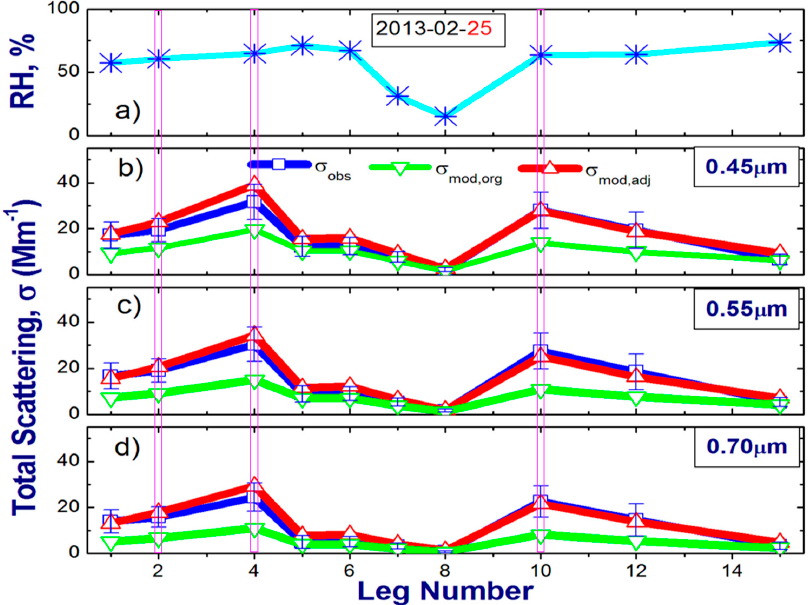
Figure 8. Ambient RH ( a ) and spectral values ( b – d ) of the total scattering coefficient measured (blue) and calculated for the original (green) and RI-based adjusted (red) size distributions for FLs on 25 February 2013 at three wavelengths: ( b ) 0.45, ( c ) 0.55, and ( d ) 0.70 μ m. Error bars represent uncertainties of measured scattering coefficients. Vertical columns (magenta) identify shallow FLs with low (<0.1 km) altitude (Figure 2).